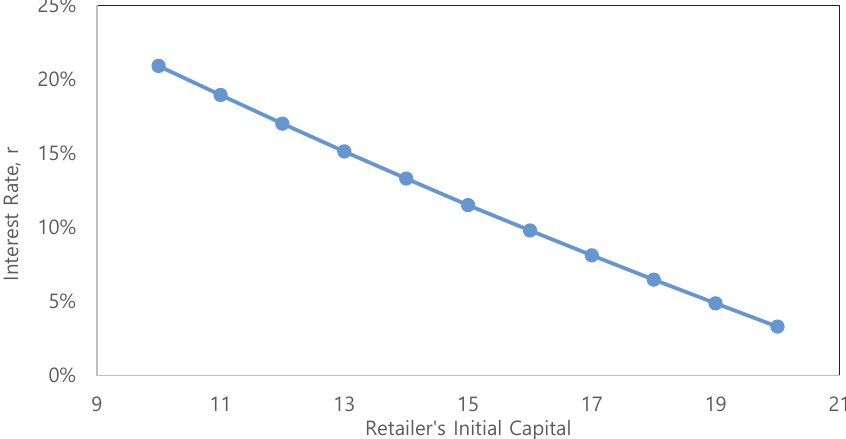
Fig. 3 Bank’s Optimal Interest Rate vs. Bank’s Coefficient of